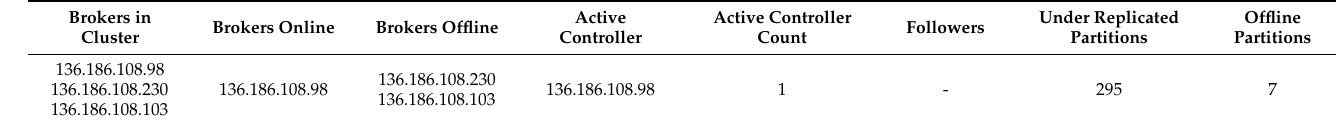
Table 3. Broker and Partition status when brokers are taken off from the cluster.